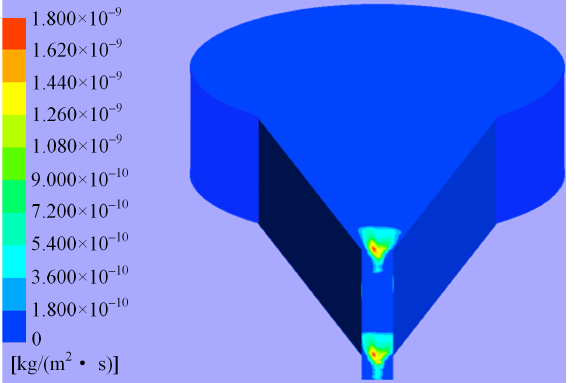
Figure 11. Erosion rates of jet orifice.